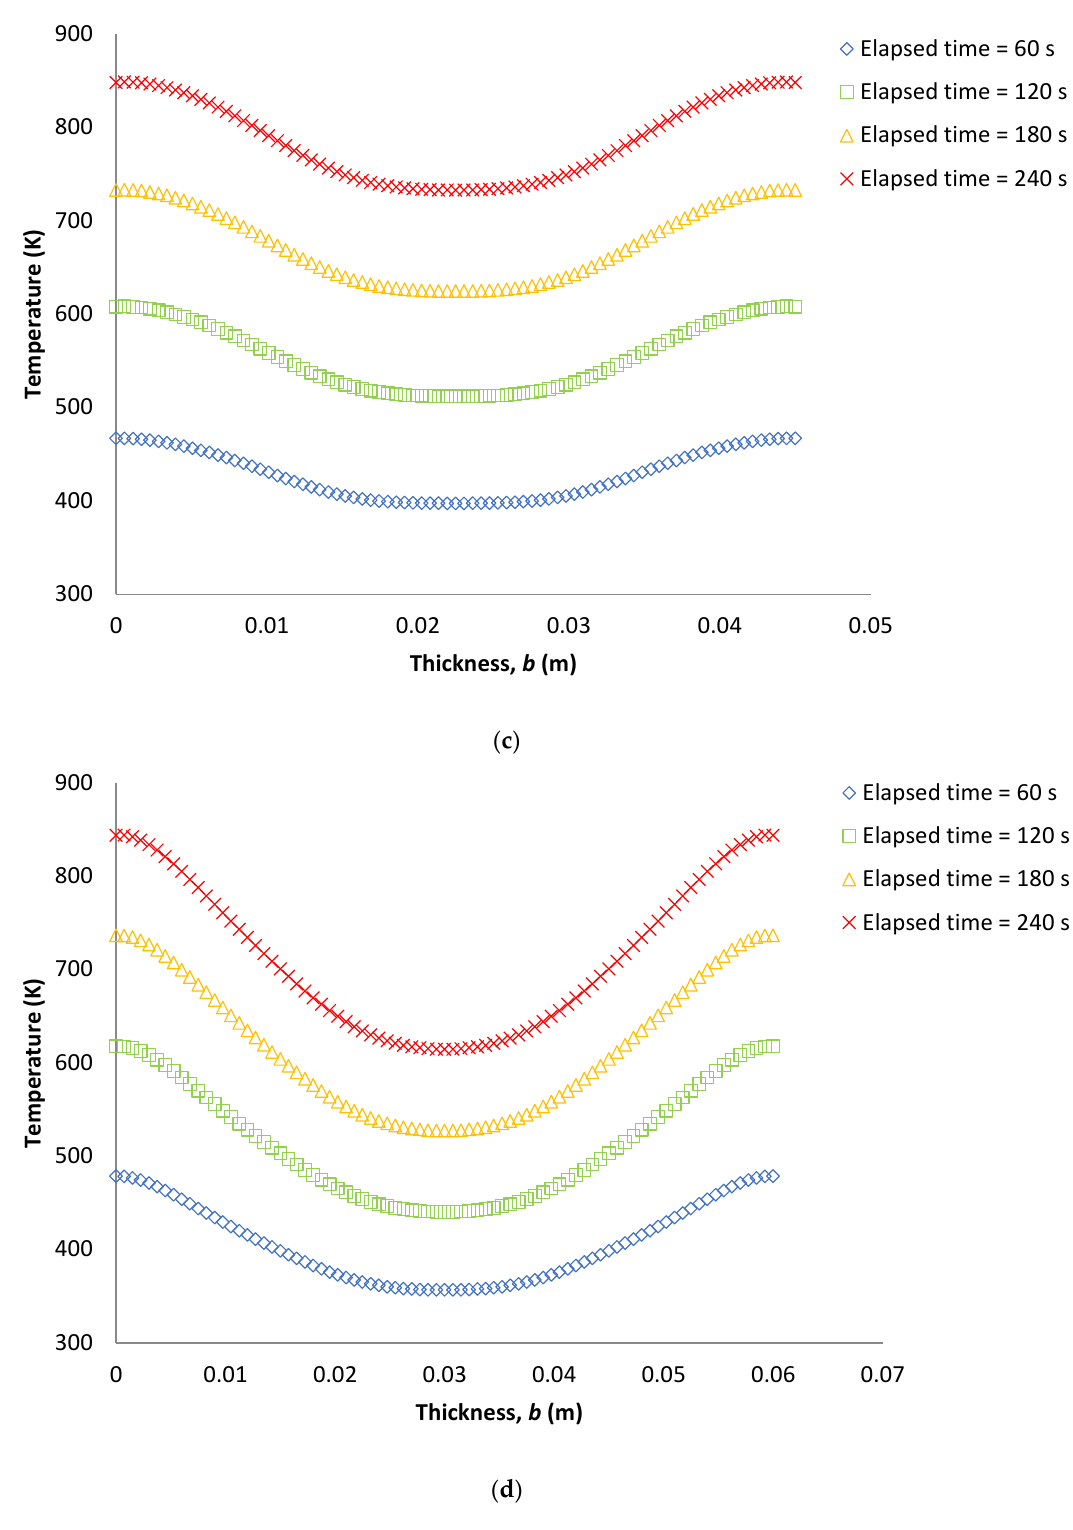
Figure A2. Temperature profiles along the center line of ilmenite slab with respect to the variation of microwave heating times for different thickness: ( a ) b = 0.015 m; ( b ) b = 0.03 m; ( c ) b = 0.045 m; ( d ) b = 0.06 m.